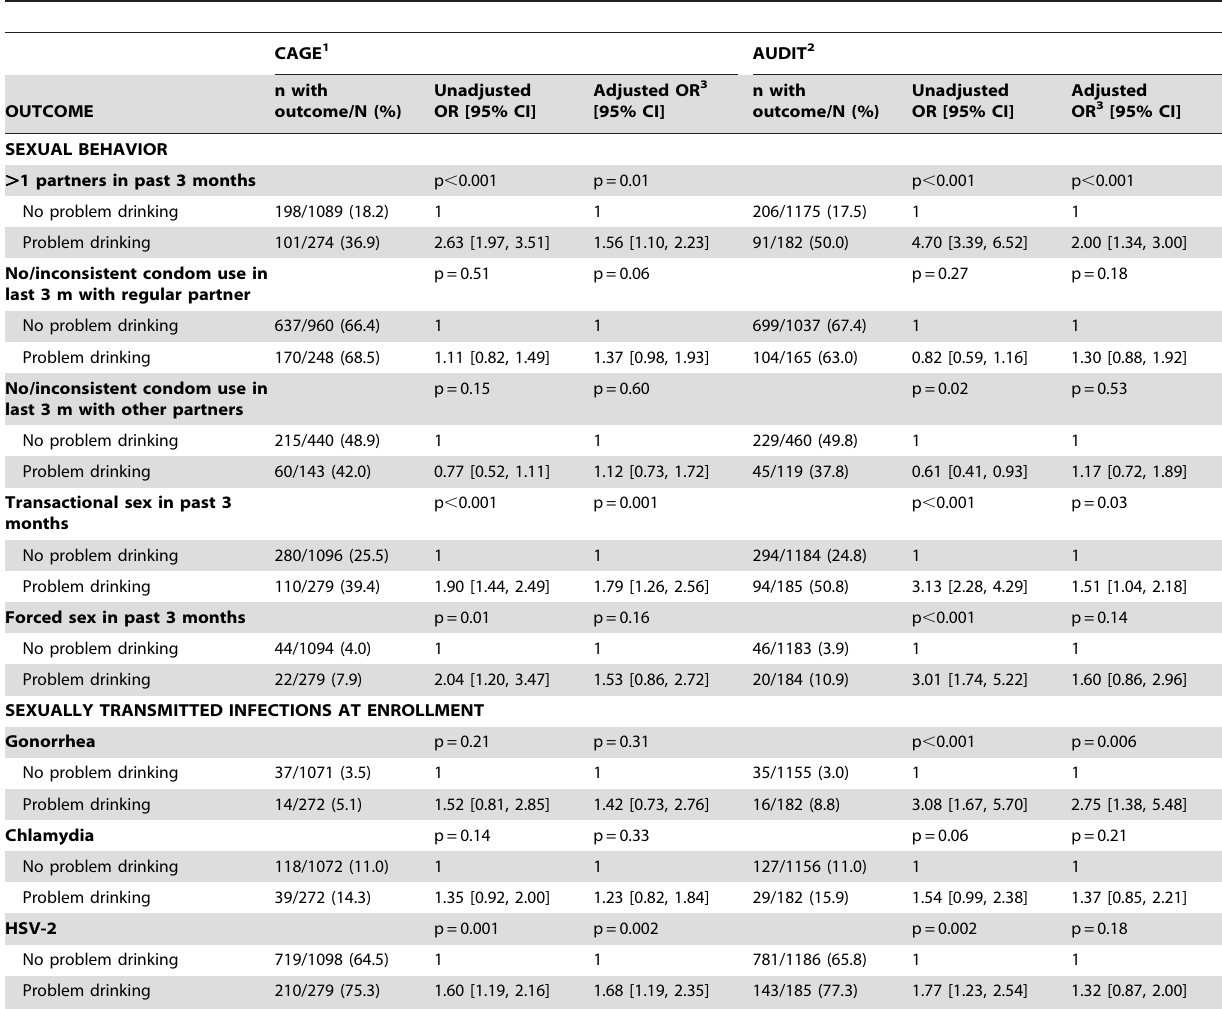
Table 4. Associations of problem drinking with reported sexual behaviors in the past 3 months and sexually transmitted infections at the time of enrollment in a cohort of women working in food and recreational facilities in northern